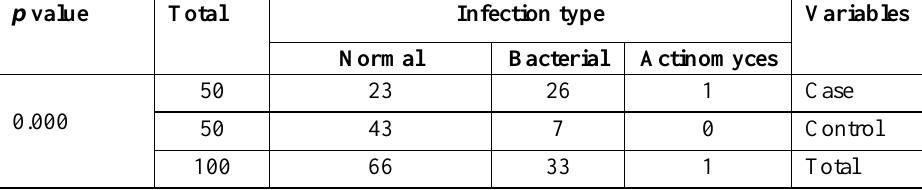
Table 5. Frequency of study population according to type of infection .